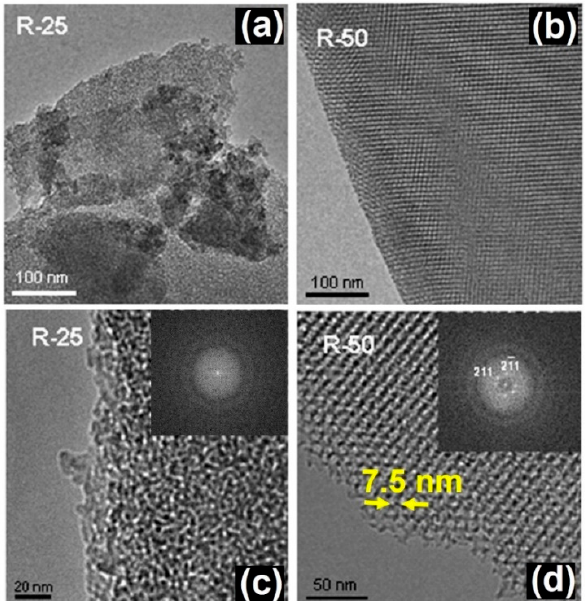
Figure 1. TEM images of RT samples with different surfactant/silica ratio corresponding to R25 ( a , c ) and R50 ( b , d ). Adapted with permission from [32]. Copyright 2008 Trans Tech Publi- cations Ltd. (Stafa-Zurich,